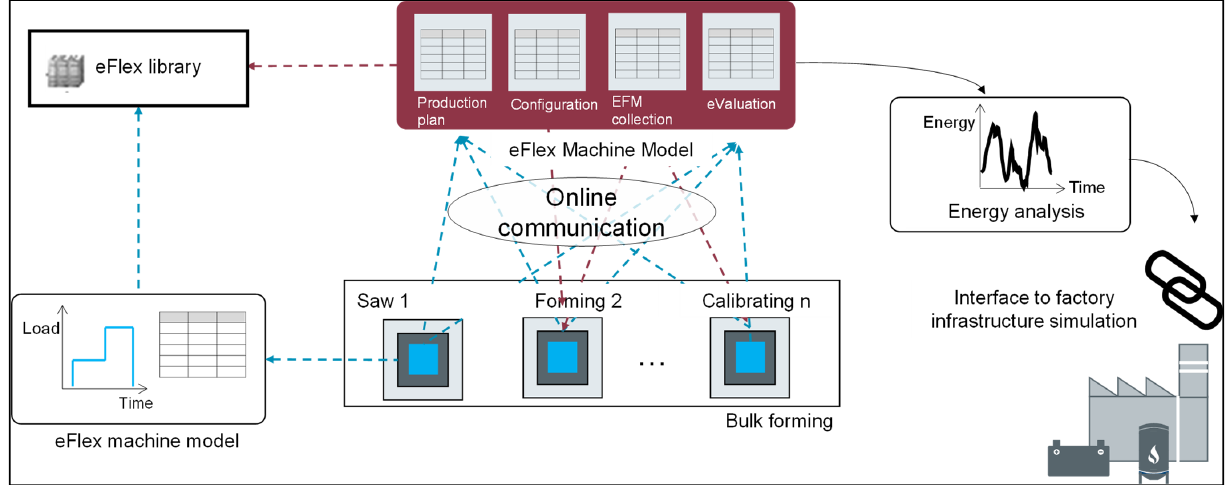
Figure 5. Schematic representation of the material and energy flows in use case 2.